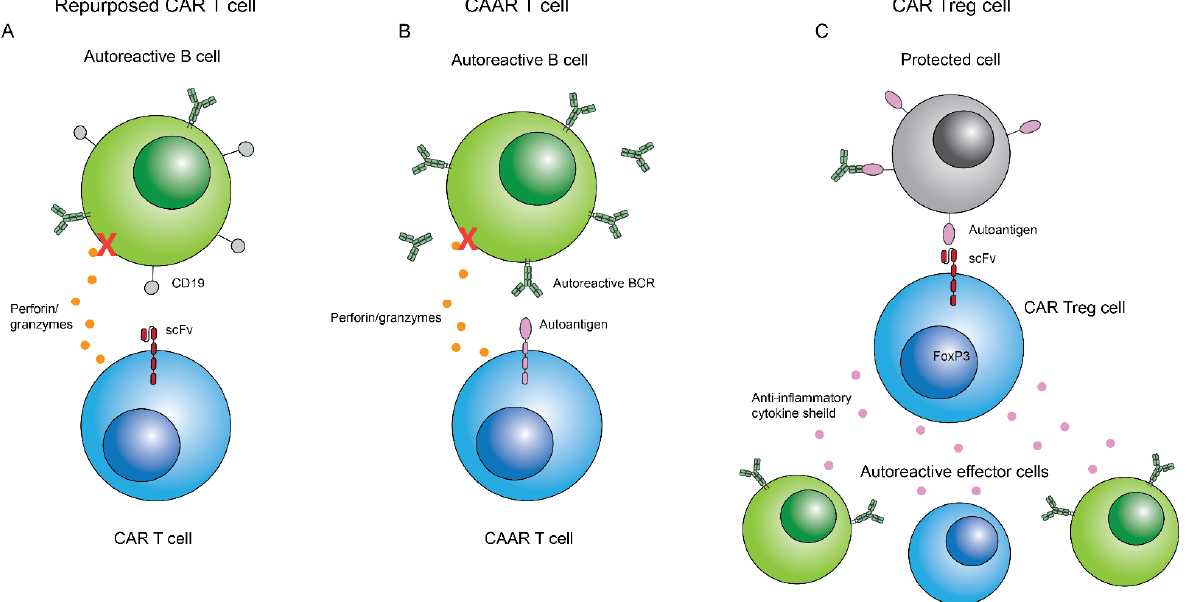
Figure 6. Three approaches to treating autoimmune disease with CAR T cells . ( A ) Repurposed CAR T cells are standard CAR T cells with scFvs generated against an epitope for an autoimmune disease. They use standard CD8 T cell killing mechanisms, including perforin and granzymes. ( B ) Chimeric autoantigen receptor (CAAR) T cells are a novel approach that use an epitope of an autoantigen as the binding domain of the CAAR T cell. This allows the CAAR T cell to bind to autoreactive B cell receptors (BCRs) and eliminate the autoreactive B cell through standard CD8 T cell mechanisms. ( C ) CAR Treg cells have an scFv against an autoantigen that has disease causing autoantibodies produced against it. The CAR Treg cell binds to this autoantigen on the cell that needs protecting and releases anti-inflammatory cytokines, producing a shield to prevent autoreactive effector T and B cells from destroying the protected